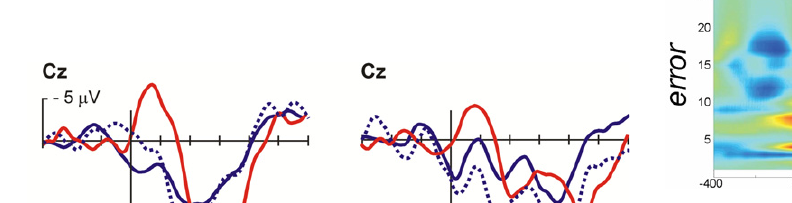
Figure 6. Time-frequency plots. Wavelet analysis of the recordings from the Nacc and the surface of the scalp (Cz-A1) recorded in parallel during the operation show performance related